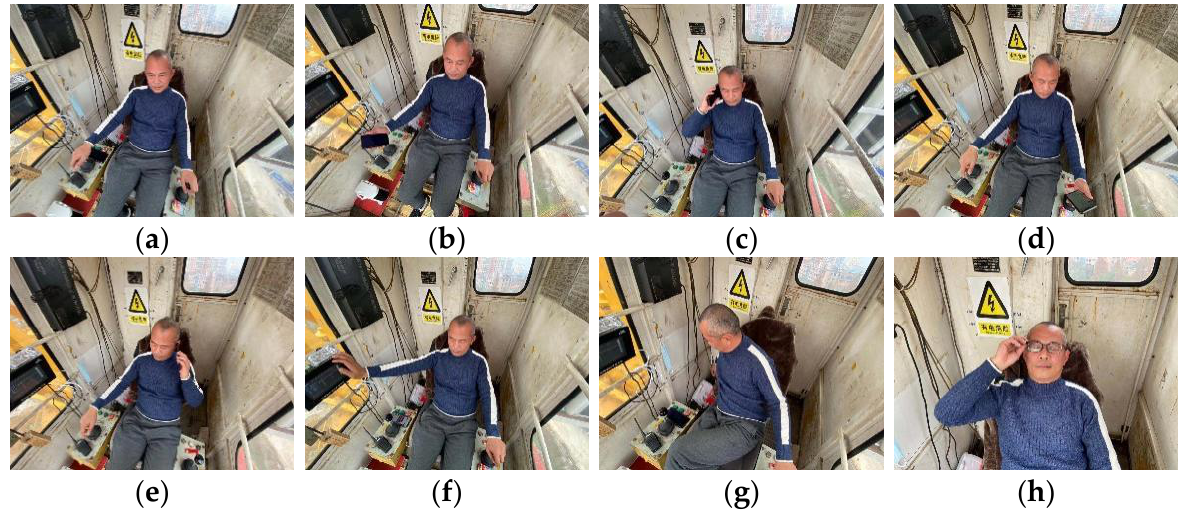
Figure 3. Example images of driver behavior. ( a ) Everyday driving. ( b ) Looking at the phone (right hand). ( c ) Calling (right hand). ( d ) Looking at the phone (left hand). ( e ) Calling (left hand). ( f ) Adjusting meters. ( g ) Holding things in the back seat. ( h ) Holding glasses.